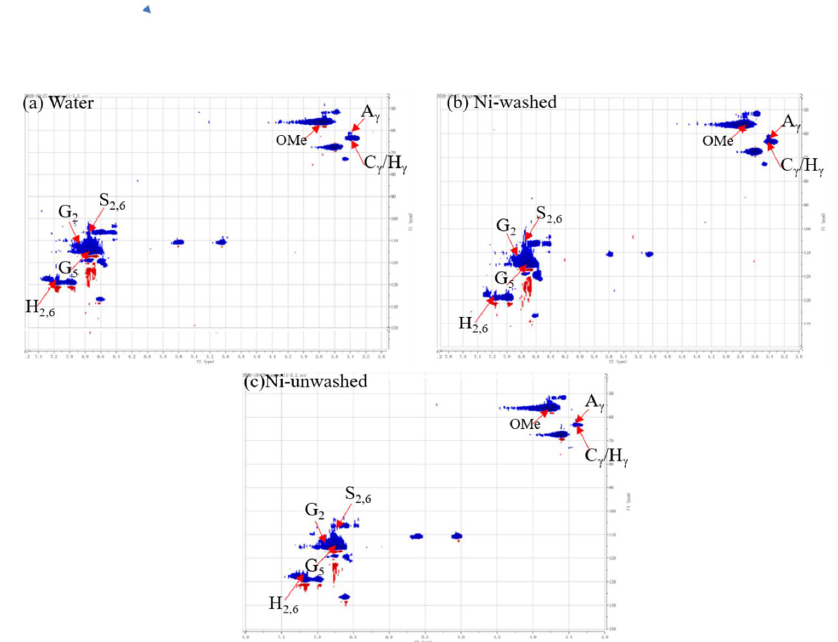
Figure 8. 2D HSQC NMR spectra of bio-oil obtained from lignin pyrolysis.